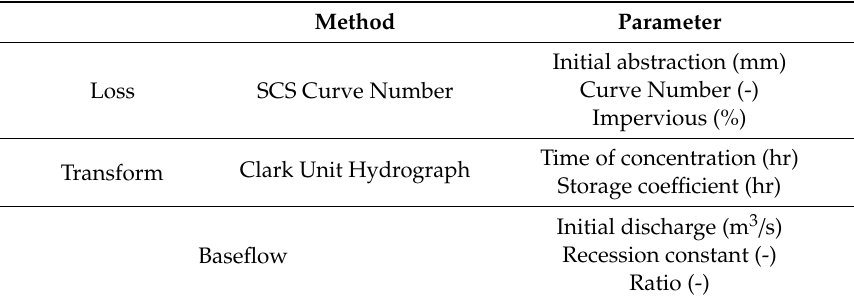
Table 3. Overview of methods employed in surface runo ff simulations using